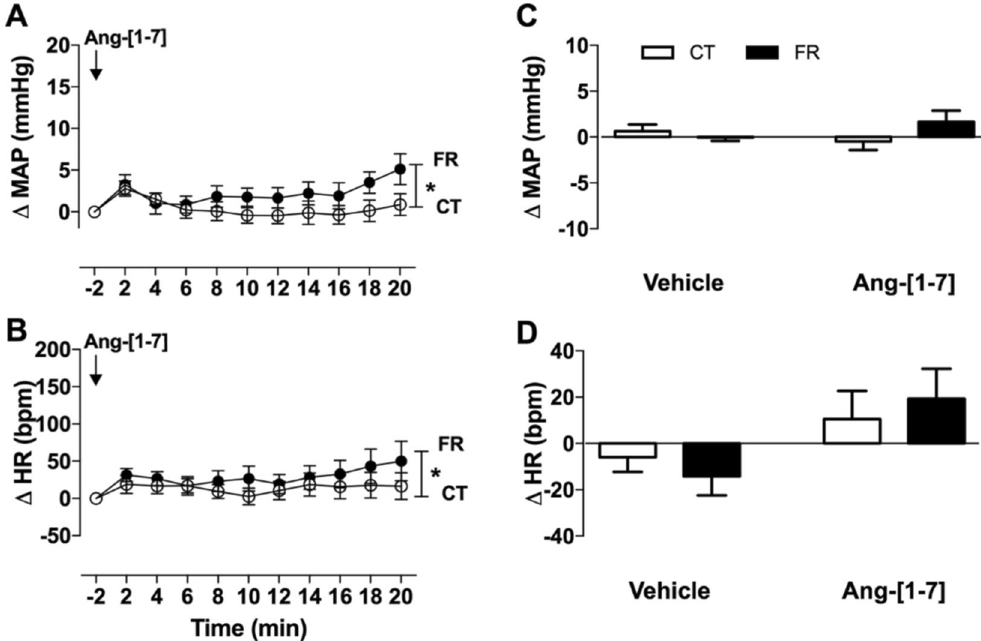
Figure 4. Effect of FR on MAP and HR responses to infusion of Ang-[1–7]. Shown are the changes ( A , B ) or maximum change from baseline ( C , D ) in MAP ( A , C ) and HR ( B , D ) after vehicle or Ang-[1–7] infusion in CT (open circle; n = 10) and FR (closed circle; n = 9) female rats. Basal MAP (mm Hg): CT, 106 ± 1 vs. FR, 104 ± 3. Basal HR (bpm): CT, 380 ± 7 vs. FR, 358 ± 12. * P < 0.05 vs. CT by two-way ANOVA and Bonferroni post-hoc test (time; diet). Values are expressed as the mean ±